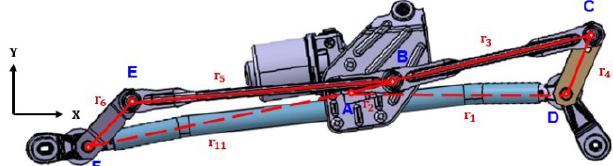
Figure 4. Structure of a center driven linkage system (CDLS).